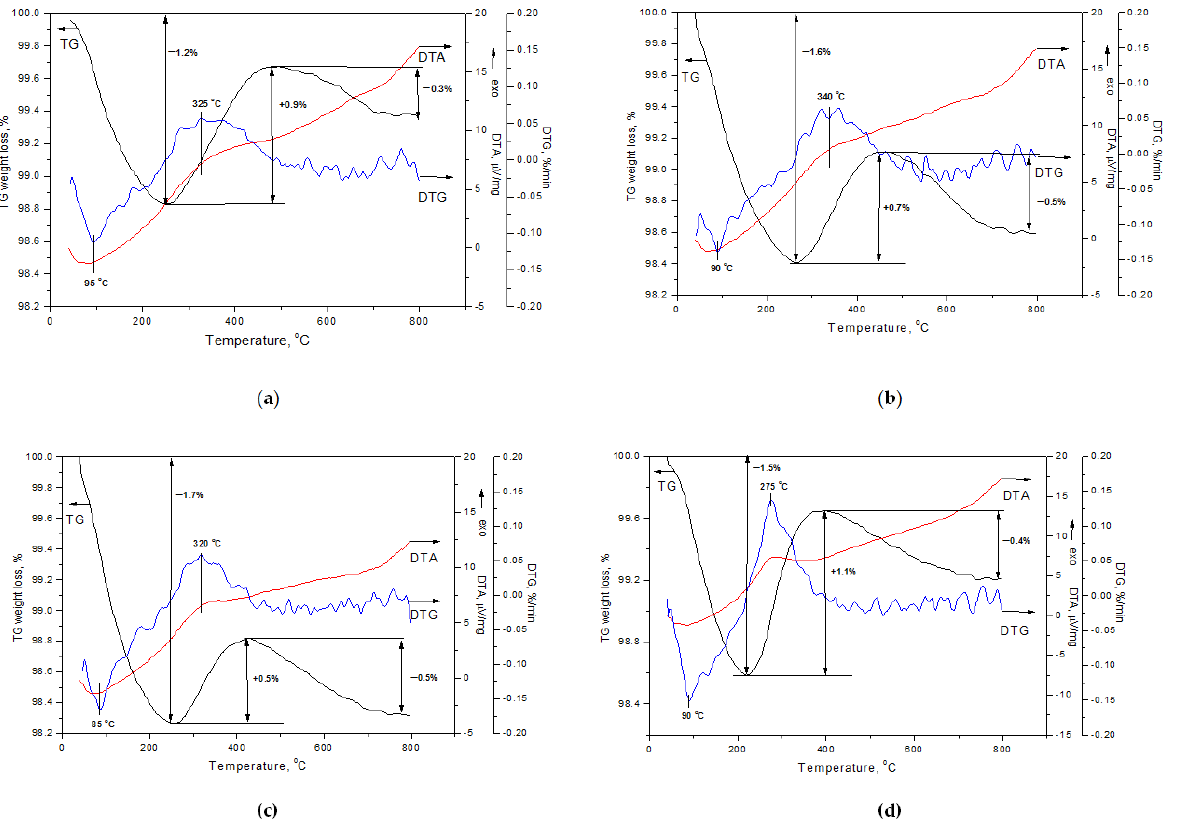
Figure 10. TG, DTG, and DTA curves for 10Ni/Al 2 O 3 -CI ( a ), 20Ce 0.2 Ni 0.8 O 1.2 /Al 2 O 3 -CI ( b ), 10Ni/Al 2 O 3 -SG ( c ), and 20Ce 0.2 Ni 0.8 O 1.2 /Al 2 O 3 -SG ( d ) catalysts after the reaction.